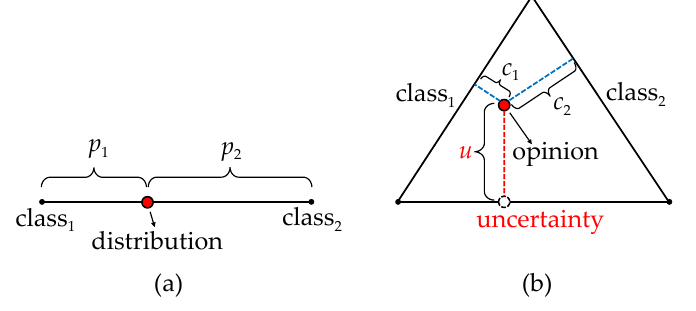
Figure 5. The case of a binary classification problem: ( a ) is the class probability distribution of a sample generated by softmax; ( b ) is the “opinion” of the sample generated by the an uncertainty estimation operation where u is the uncertainty and c i is the credibility of class i